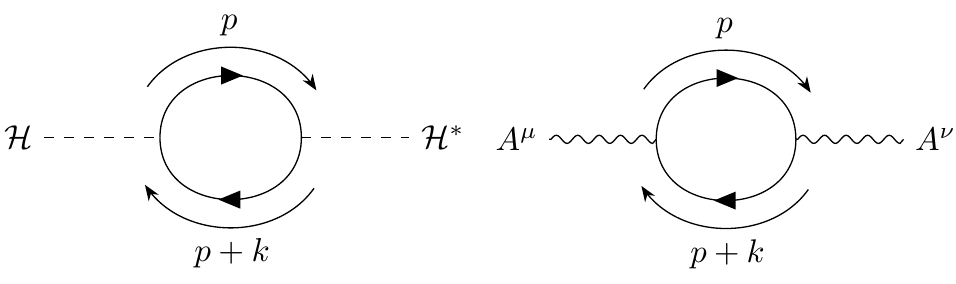
Figure 3 . The effective action for the Higgs boson (left) and U(1) gauge field (right) are generated by the fermions at leading order in a 1 /N f